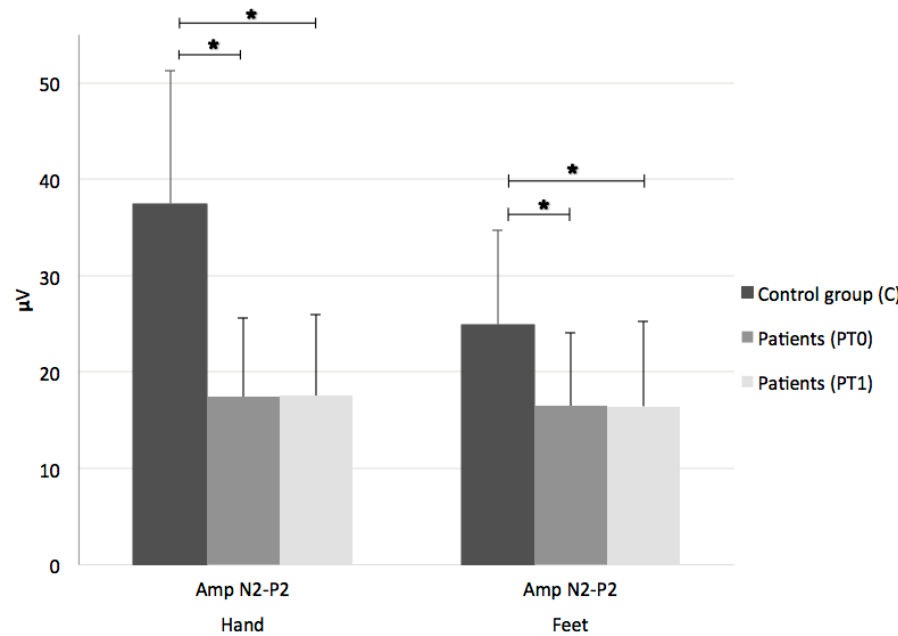
Figure 1. Laser-evoked potentials’ mean N2-P2 complex amplitudes for dominant hand and feet in control group (C) and patients before (PT0) and after (PT1) Sativex ® . N2–P2 complex amplitudes in MS patients are significantly reduced in both dominant hand and feet compared to controls. No changes are observed after therapy. Amp: amplitude; *: statistically significant.